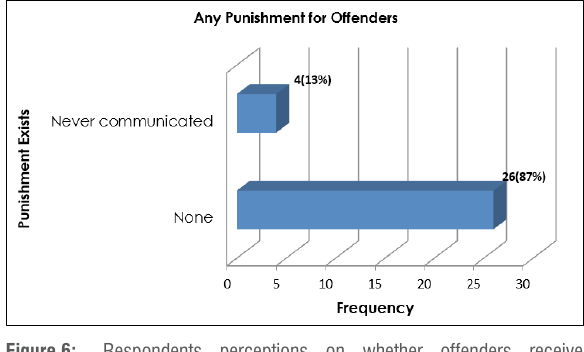
Figure 6: Respondents perceptions on whether offenders receive punishment and on whether the punishment is communicated to their victims.